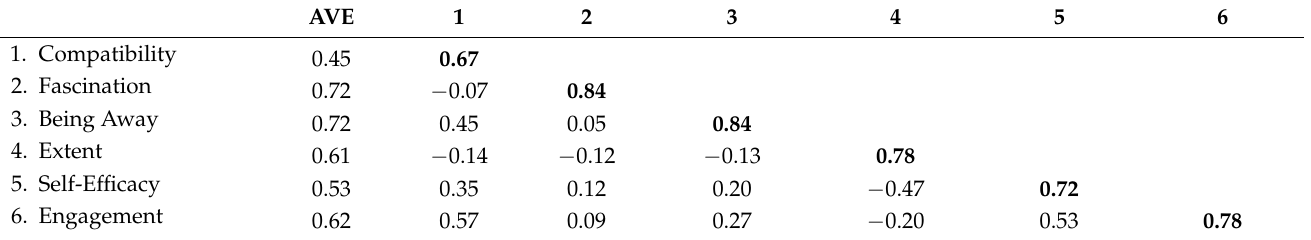
Table 2. Average variance extracted (AVE), AVE root square, discriminant validity and